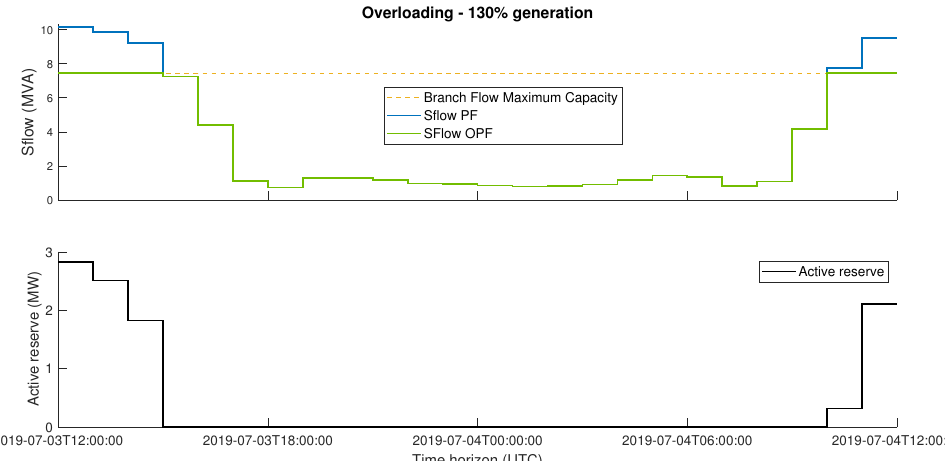
Figure 6. MPOPF impact on the congested transmission line and the corresponding control-actions (30% generation increase).